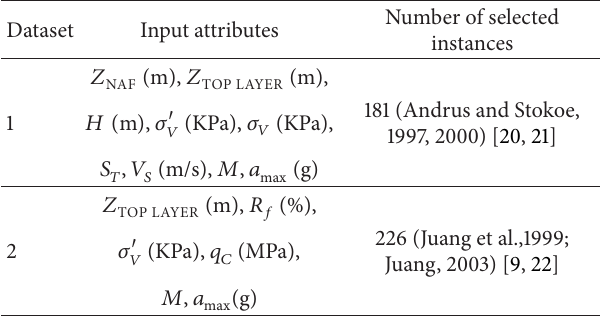
Table 2: Database used to construct the ML model.